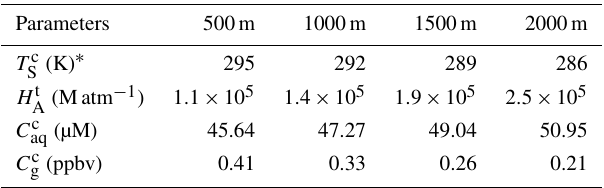
Figure 3. The measured and predicted H 2 O 2 levels in a rain event on 1–2 September 2018. (a) Measured gas-phase H 2 O 2 ( C m g ). (b) The difference between measured ( C m aq ) and theoretical ( C t aq ) levels of H 2 O 2 in the liquid phase. The red box indicates a sudden rise in gas-phase H 2 O 2 . Table 2. Estimates of the level of H 2 O 2 in cloud water ( C c aq ) and the surrounding atmosphere ( C c g ) at different fall distances with a raindrop diameter of